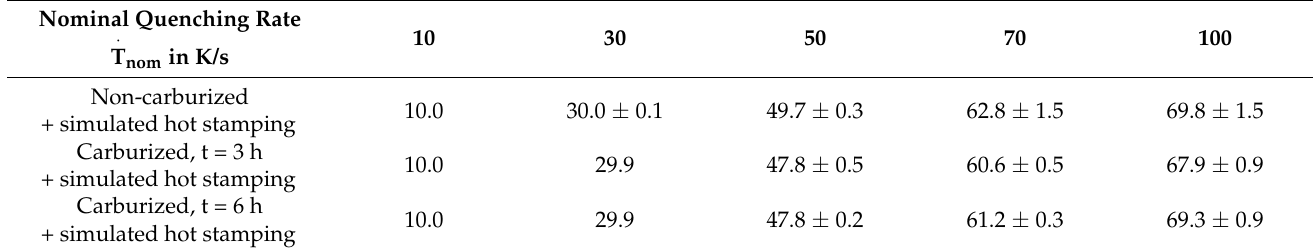
Table 2. Average quenching rates between 800 °C and 250 °C .